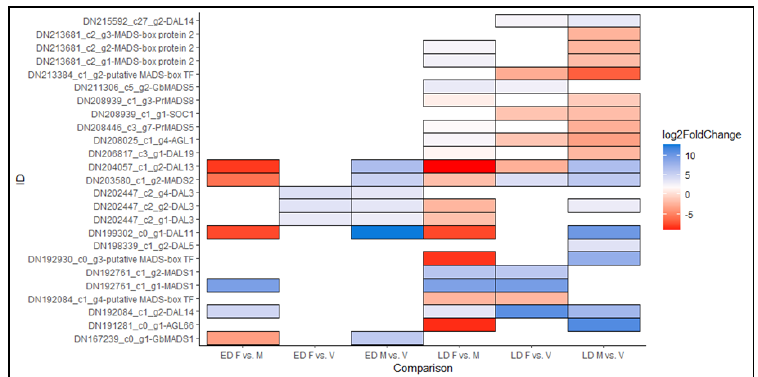
Figure 6. MADS-box TFs differentially expressed in six comparisons. Gene ID is composed of the TRINITY accession ID, followed by NCBI BLASTP derived homolog gene. ED, Early development (Stage 2); LD, Late development (Stage 3); F, female; V, vegetative; M, male. 3.7. Differentially Expressed TF Involved in Male Cone Differentiation Seven genes, including homologs of MADS1 , MADS2 , DAL3 , DAL11 and DAL13 , were up-regulated in early differentiating male cones. Late differentiated male cones were the most prominent bud type in terms of the magnitude of DE MADS-box genes, with nine up-regulated genes ( DAL3 , DAL5 , DAL11 , DAL13 , DAL14 , MADS2 , AGL66 , and a putative MADS-box homologous gene), and seven down-regulated genes ( MADS-box 2 , MADS8 , SOC1 , MADS5 , AGL1 , DAL19 , and a putative MADS-box homologous